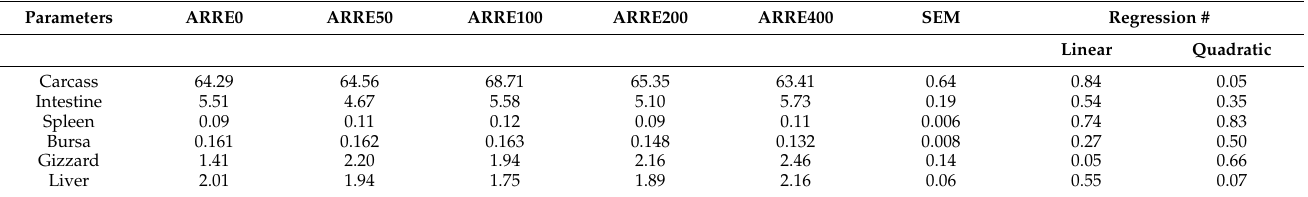
Table 3. The effect of dietary supplementation of ARRE on the carcass traits (%) relative to live